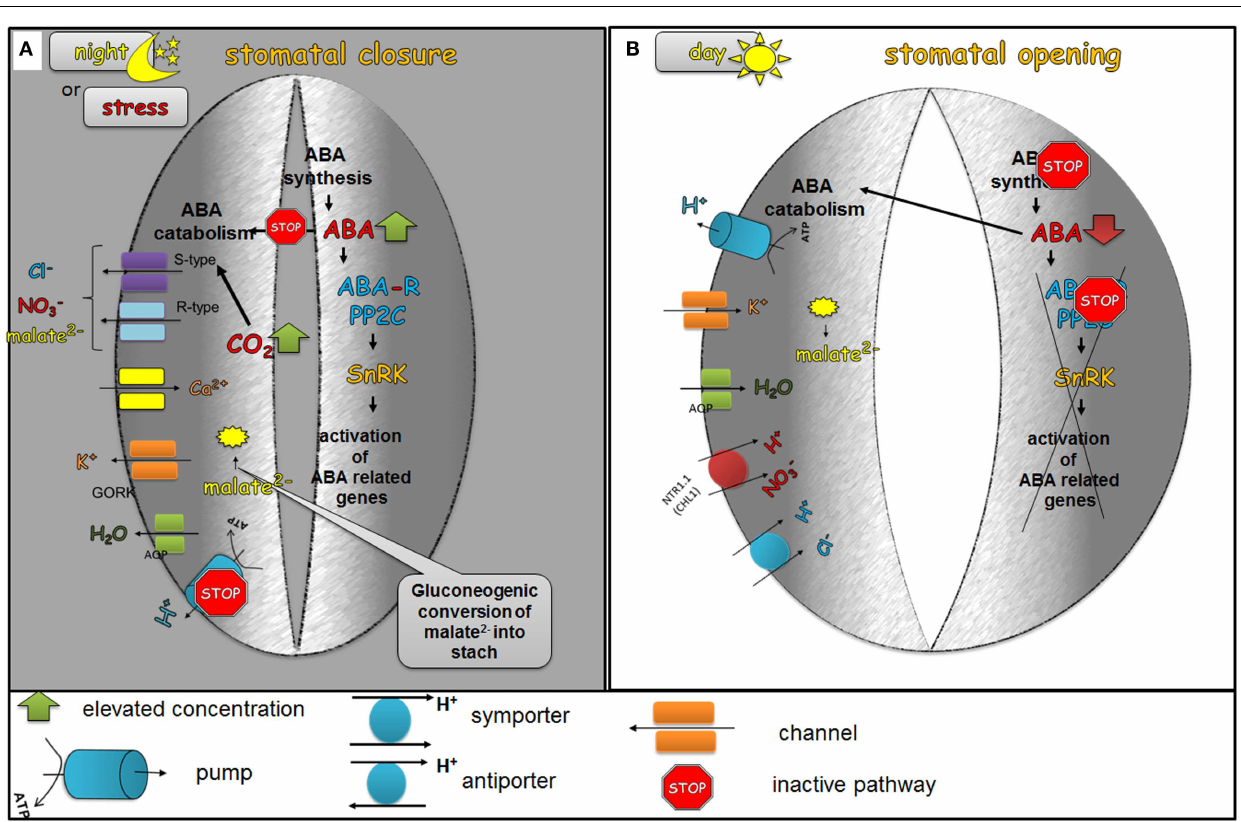
caused by the gluconeogenic conversion of malate into starch. In the dawn (B) , the first light promotes ABA catabolism processes and the level of ABA biosynthesis decreases, which leads to a decreased concentration of active ABA in the guard cells. Low endogenous ABA levels no longer inhibit H + -ATPase (H + -pump), which is then able to extrude H + from the guard cells. At the same time, the accumulation of water and ions, such as K + , Cl − , , the 3 malate 2 − occurs in order to generate the turgor that is needed to keep stomata